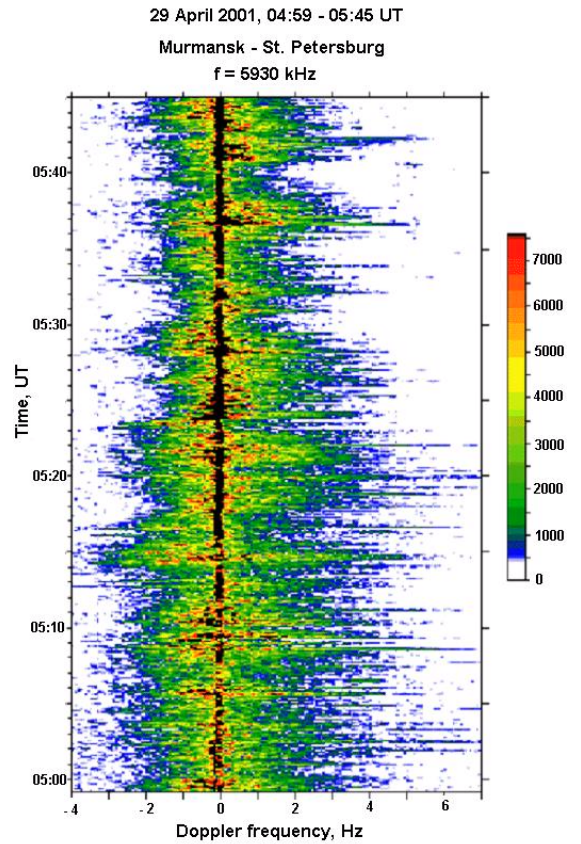
Fig. 7. Sonogram for Murmansk-St. Petersburg between 16:26 and 16:45 UT on 28 April 2001. Numbers on the colour scale are power spectrum values, arbitrary units.